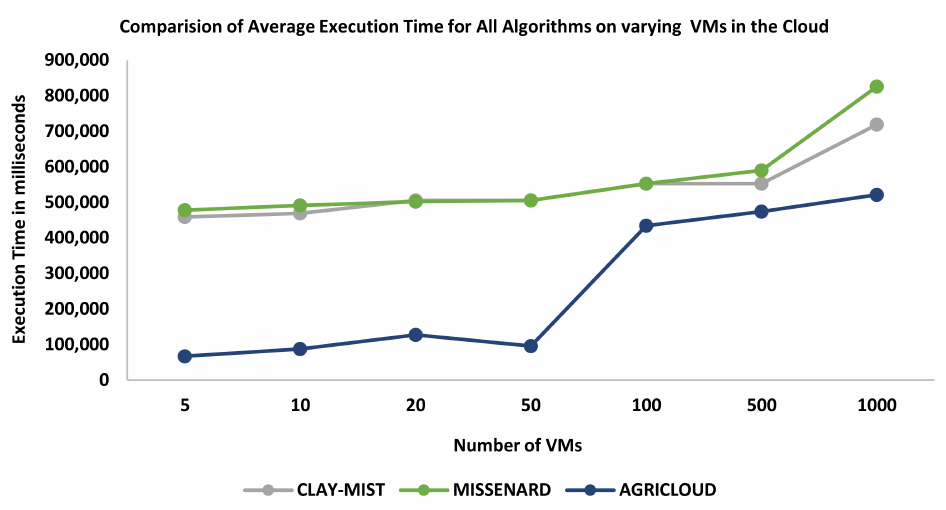
Figure 2. Execution time of AGRICLOUD with